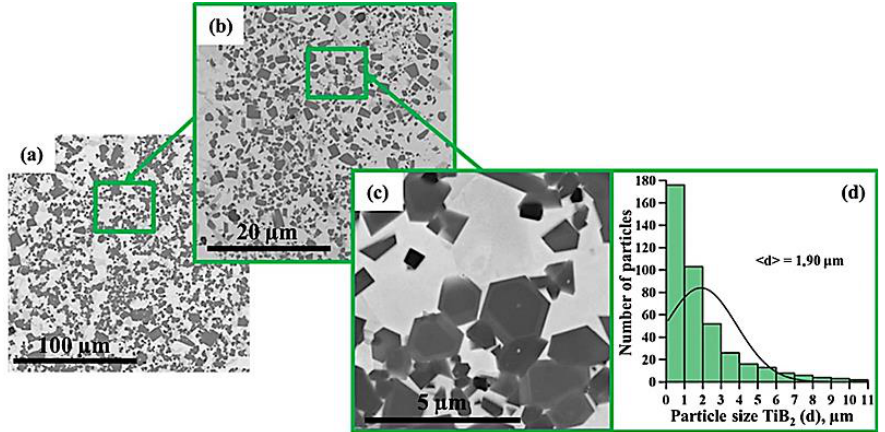
Figure 7. SEM image of the structure of a composite fabricated by direct laser deposition from the Inconel 625 + 30 wt% NiTi – TiB 2 powder mixture ( a – c ), histogram of the distribution of ceramic in- clusions by size ( d ).